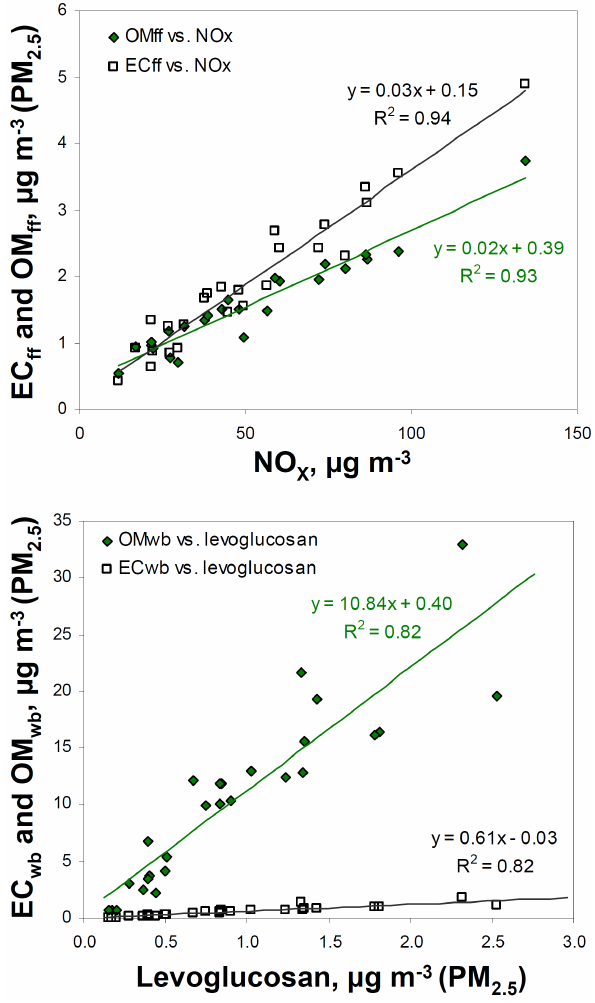
Figure 8 Fig. 8. Scatterplots of EC ff and OM ff as well as of EC wb and OM wb , as calculated by the Aethalometer model, versus NO x and levoglucosan concentrations respectively.